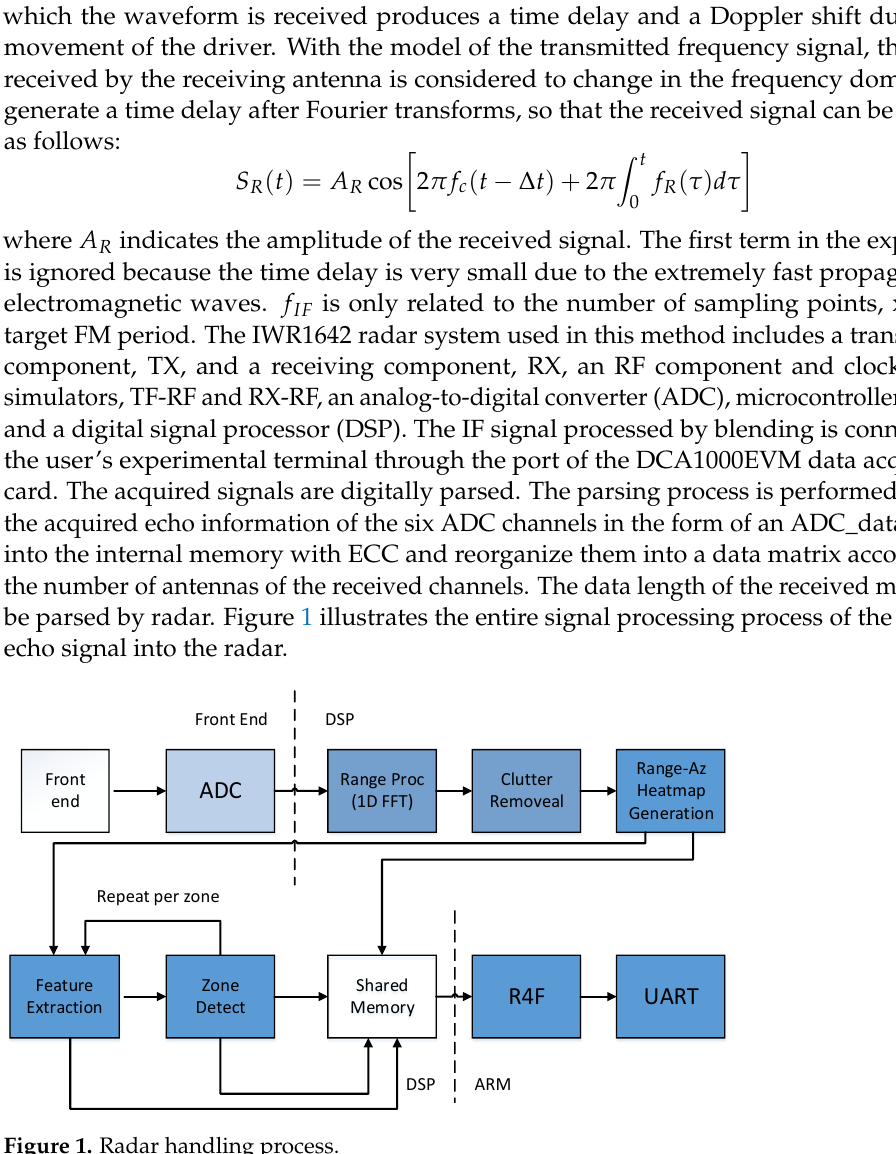
Figure 1. Radar handling process.